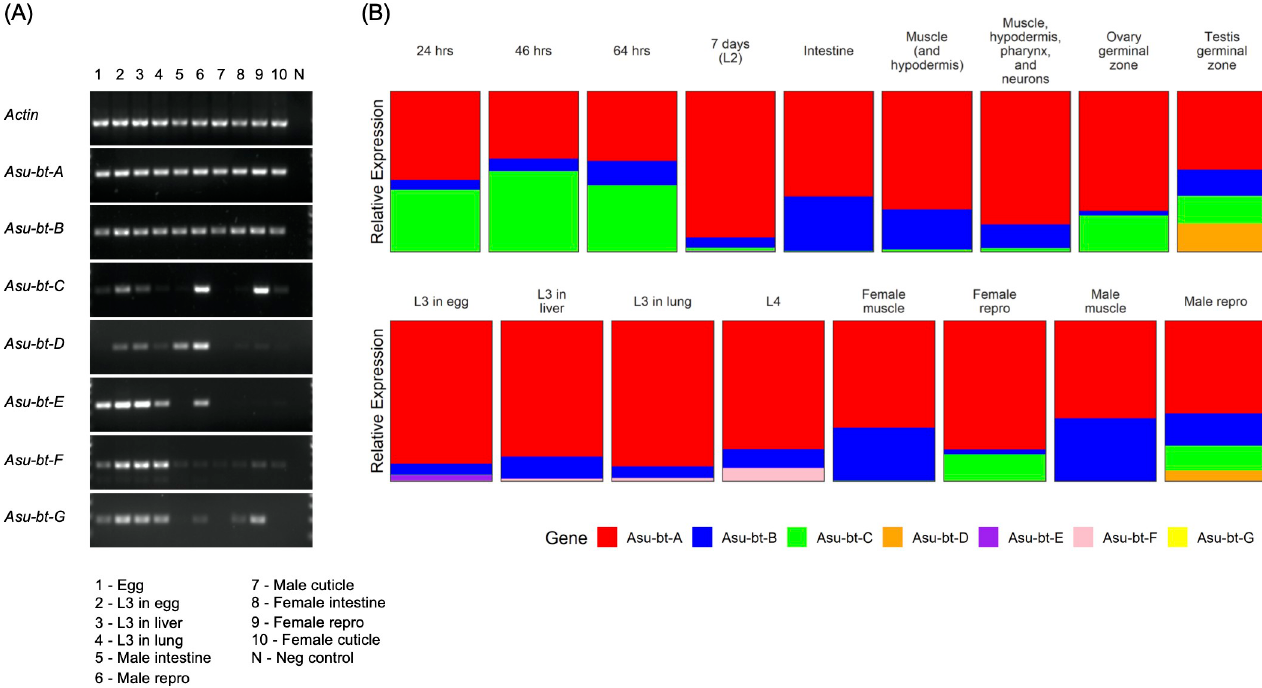
Fig 3. Transcription profiles of the β -tubulins of Ascaris suum . Panel A. Reverse transcription (RT)-PCR analyses were performed on cDNA samples with gene specific primer sets. The agarose gels show the transcription profiles of the β -tubulins in four developmental stages (egg, third larval stage (L3) in egg, L3 in liver, L3 in lung) and three tissue types of adult male and female worms (intestinal, reproductive, and cuticle). Panel B. RNA-seq analyses were performed using RNA-seq data obtained from the NCBI Sequence Read Archive. The stacked bar charts show the expression of each β -tubulin (relative to total β -tubulin expression) in different developmental stages (24h embryos to L4 stage larvae) and different tissue types of A . suum